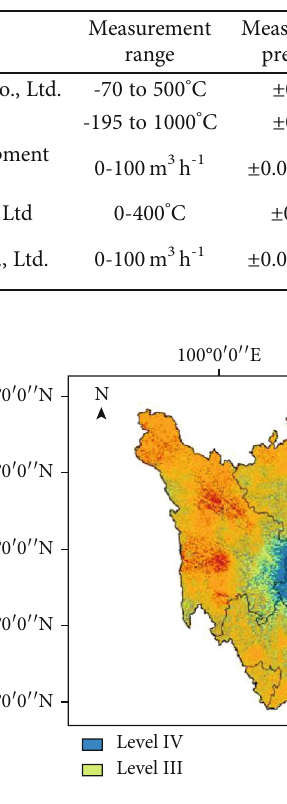
Table 3: Characteristics of the measuring instrument.